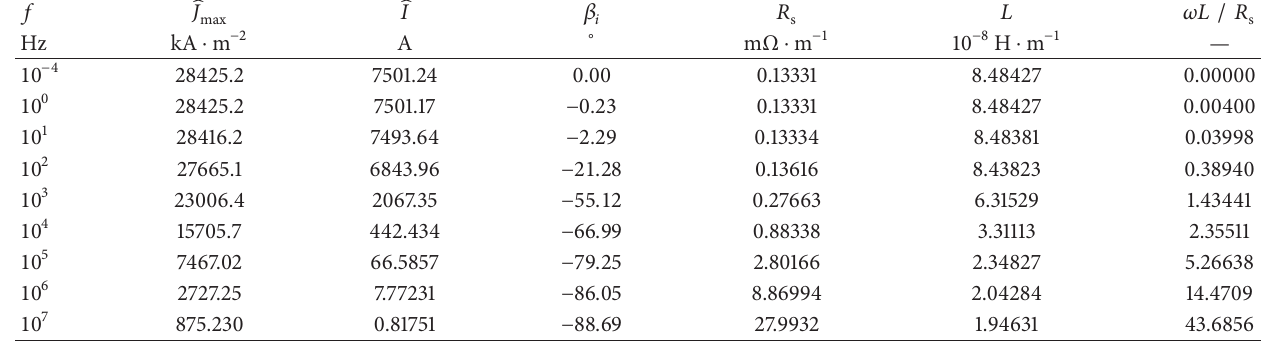
Table 3: Dependence of some quantities characterizing pair of conductors in Example 1 on 𝑓 .